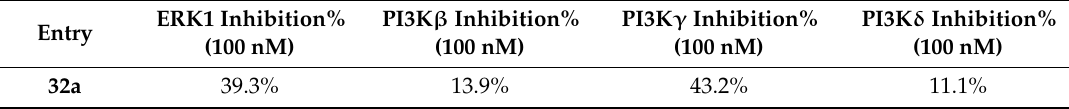
Table 5. In vitro ERK 1, PI3K β , PI3K γ and PI3K δ inhibitory activities of compound 32d .